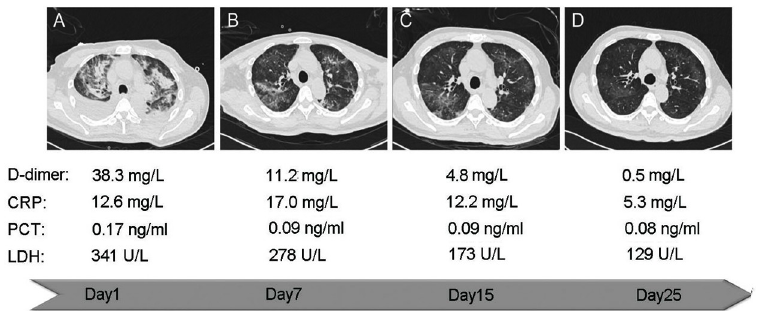
Fig 3. Representative computed tomography of a 62-year-old male patient during adjuvant antithrombotic treatment. Abidol and Ibuprofen was taken orally by the patient intermittently. After admission, the combination of anticoagulation was used (Aspirin enteric-coated tablets 100mg once a day and Clopidogrel bisulfate tablet 75mg once a day). The representative CT and the blood test results during the treatment were shown as A-D. (A) The infection was severe, and the diffuse distribution of the infection foci was dominated by bilateral pleural effusion. The D-dimer level was very high (38.3 mg/L). (B) The infection foci of the bilateral upper lung were reduced, and bilateral pleural effusion had been absorbed by itself. (C) The foci were reduced continuously and were mainly in the right upper lung at this time. (D) The infection foci were almost completely absorbed, while the D-dimer level of patient close to normal (0.5